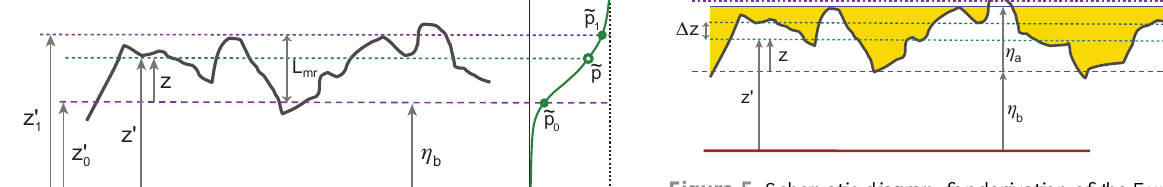
Figure 5. Schematic diagram for derivation of the Exner equation of sediment continuity over a bedrock surface (dark-grey line). As in Figs. (3) and (4), z is the elevation above the effective “bottom” of Figure 4. Illustration of the statistical structure or local hypsometry the bedrock relief, L mr is macro-roughness height, η b is elevation of the bedrock surface topography (dark-grey line). Here z (cid:48) denotes at base of the bedrock and η a is the thickness of alluvium (yellow an elevation above some arbitrary datum (dark-red line) deep in the fill). The diagram shows alluvium–water interfaces (blue line) that bedrock and e p(z (cid:48) ) is the probability (green line, marker) that a point are at spatially constant elevations. This is for illustrative purposes at elevation z (cid:48) is in water or alluvium rather than bedrock, i.e., above only; the interfaces should instead be those that result from averag- the local bedrock surface. The effective “bottom” of the bedrock re- ing over an appropriate spatial window, i.e., alluvial fill levels are = η lief is located at elevation z (cid:48) b , where e p takes an appropriately 0 expected to vary from one pocket in the bedrock relief to selected low value e p 1 (e.g., 0.05); the effective “top” of the bedrock relief is located at elevation z (cid:48) , where e p takes an appropriately se- 1 lected high value e p 1 (e.g., 0.95); and the macro-roughness L mr is − z (cid:48) given as z (cid:48) . The coordinate z = z (cid:48) − z (cid:48) is referenced to the ef- 1 0 0 fective “bottom” of the bedrock relief.